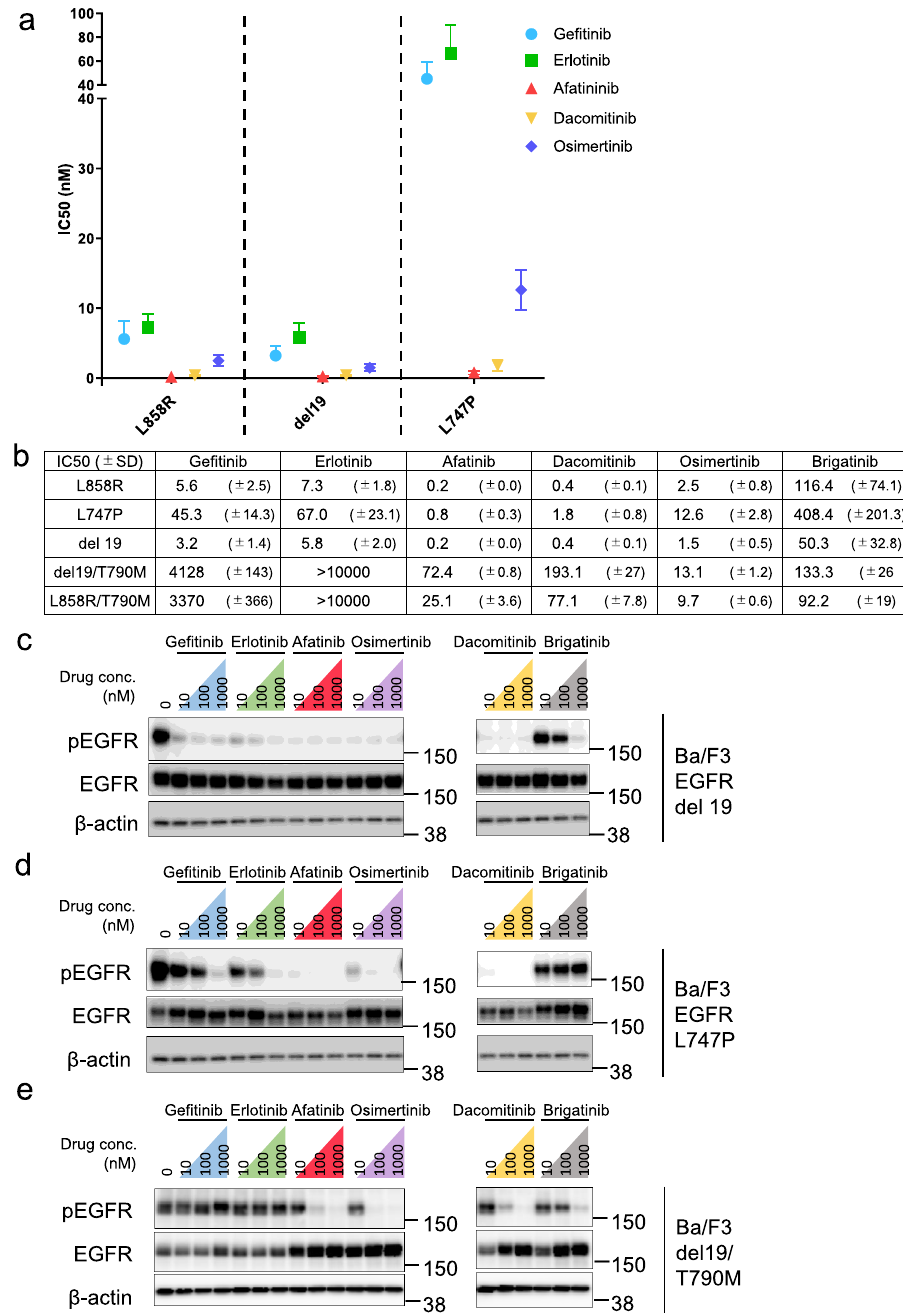
Fig. 2 Drug sensitivity pro fi le of EGFR-TKI of EGFR-L747P mutation. a EGFR gene mutations, EGFR exon 19 deletions, exon 21 L858R, and exon 19 L747P were introduced into Ba/F3 cells. EGFR mutant Ba/F3 cells were treated with ge fi tinib, erlotinib, afatinib, dacomitinib, and osimertinib. After 72 h of drug treatment, cell viability was measured using the CellTiter-Glo assay ( n = 3). b Average IC 50 value of each Ba/F3 cell for EGFR-TKIs is shown, obtained using the CellTiter-Glo assay. Results are expressed as mean ± SD calculated from the 3 experimental replicates. IC 50 values were calculated using the CellTiter-Glo assay. c – e Suppression of phosphorylated EGFR in EGFR gene-transfected Ba/F3 cells by EGFR-TKI treatment. Cells were exposed to increasing concentrations of each inhibitor (10, 100, and 1000 nM) for 8 h and then immunoblotted for cell lysates to detect the indicated addition, in high AXL protein-expressing cells, the inhibition of resistance. Several mechanisms have been reported as the primary mutant EGFR by EGFR-TKI activates AXL through the inhibition of resistance mechanisms. For example, BIM polymorphism, with a SPRY4 and induces resistance by promoting survival signaling certain deletion polymorphism in the intron of the BIM gene, was through AXL 31 . Among the primary resistant cases, a certain shown to be related to the reduced expression of the proapoptotic form of BIM protein-containing BH3 domain that number of EGFR-L747P mutations might also be included, at least results in apoptosis resistance induced by EGFR-TKI treatment 30 . In in the fi rst-generation EGFR-TKI-treated patients, and second